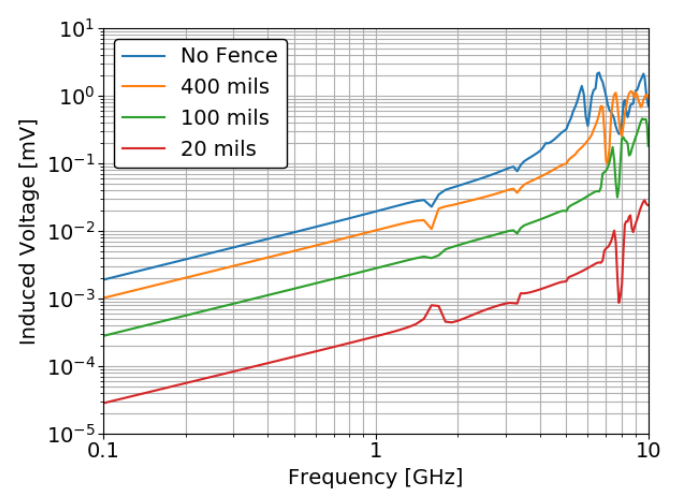
Figure 6. Induced voltage on the power plane of a four-layer ideal PCB with varying via fencing